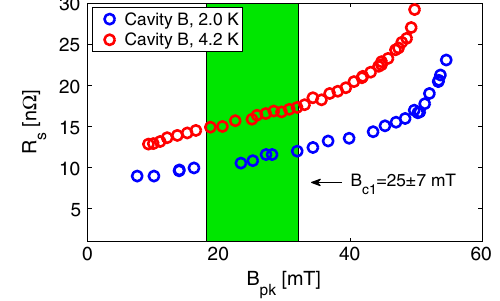
FIG. 10. R s vs T (left) and λ vs T (right) of cavity B and combined polymorphic BCS fit.